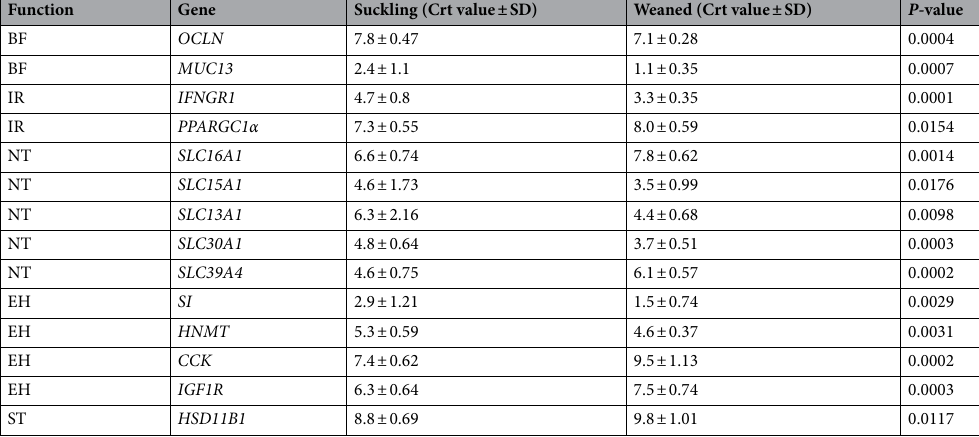
Table 2. Statistically significant differences observed in jejunal gene expression between suckling and weaned piglets. Values are expressed as Crt values ± Standard Deviation. Each analysed gene was classified based on its functionally: barrier function (BF), immune response (IR), nutrient transport (NT), enzyme/ hormone encoders (EH) or stress indicators (ST). The p -values have been adjusted by the FDR method. A brief description of the genes analysed is given in Supplementary Table S1.